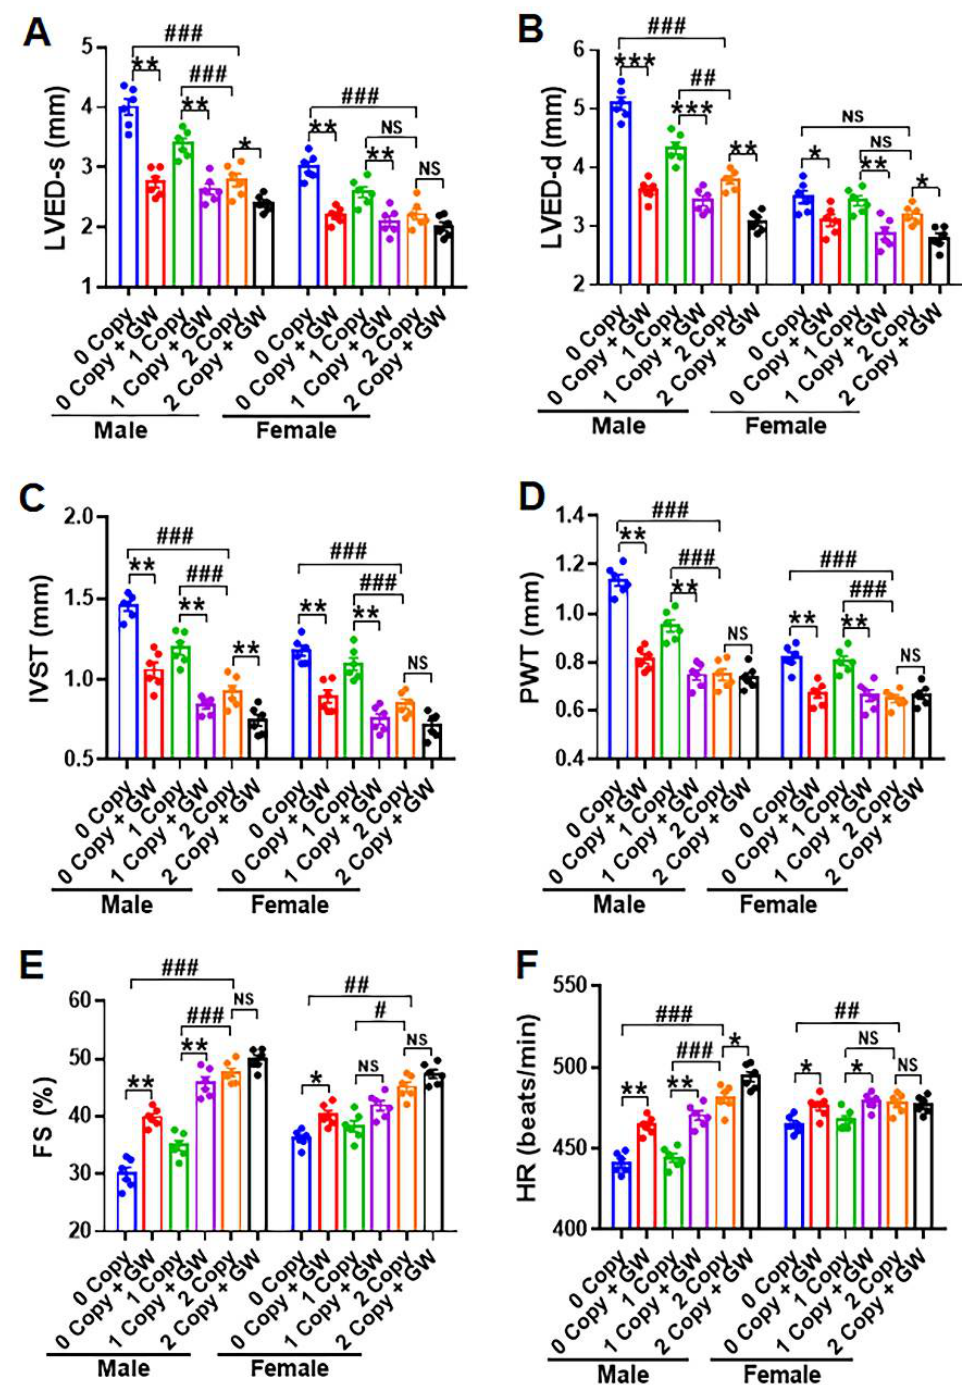
Figure 9. Sex-based echocardiographic analyses of cardiac structures and functions in male and female Npr1 mutant and control mice: left ventricular end systolic dimension (LVED-s); left ventricular end diastolic dimension (LVED-d); interventricular septal wall thickness (IVST); posterior wall thickness (PWT); fractional shortening (FS); and heart rate (HR) are presented from male and female mice (panels ( A – F )). Values are expressed as means ± S.E. (n = 6 animals in each group). Statistical significance is expressed as # p < 0.05, ## p < 0.01, ### p < 0.001, vehicle-treated 0-copy and 1-copy vs. 2-copy; * p < 0.05, ** p < 0.01, *** p < 0.001, vehicle-treated 0-copy, 1-copy and 2-copy vs. drug-treated same gene copy number. NS: not significant.